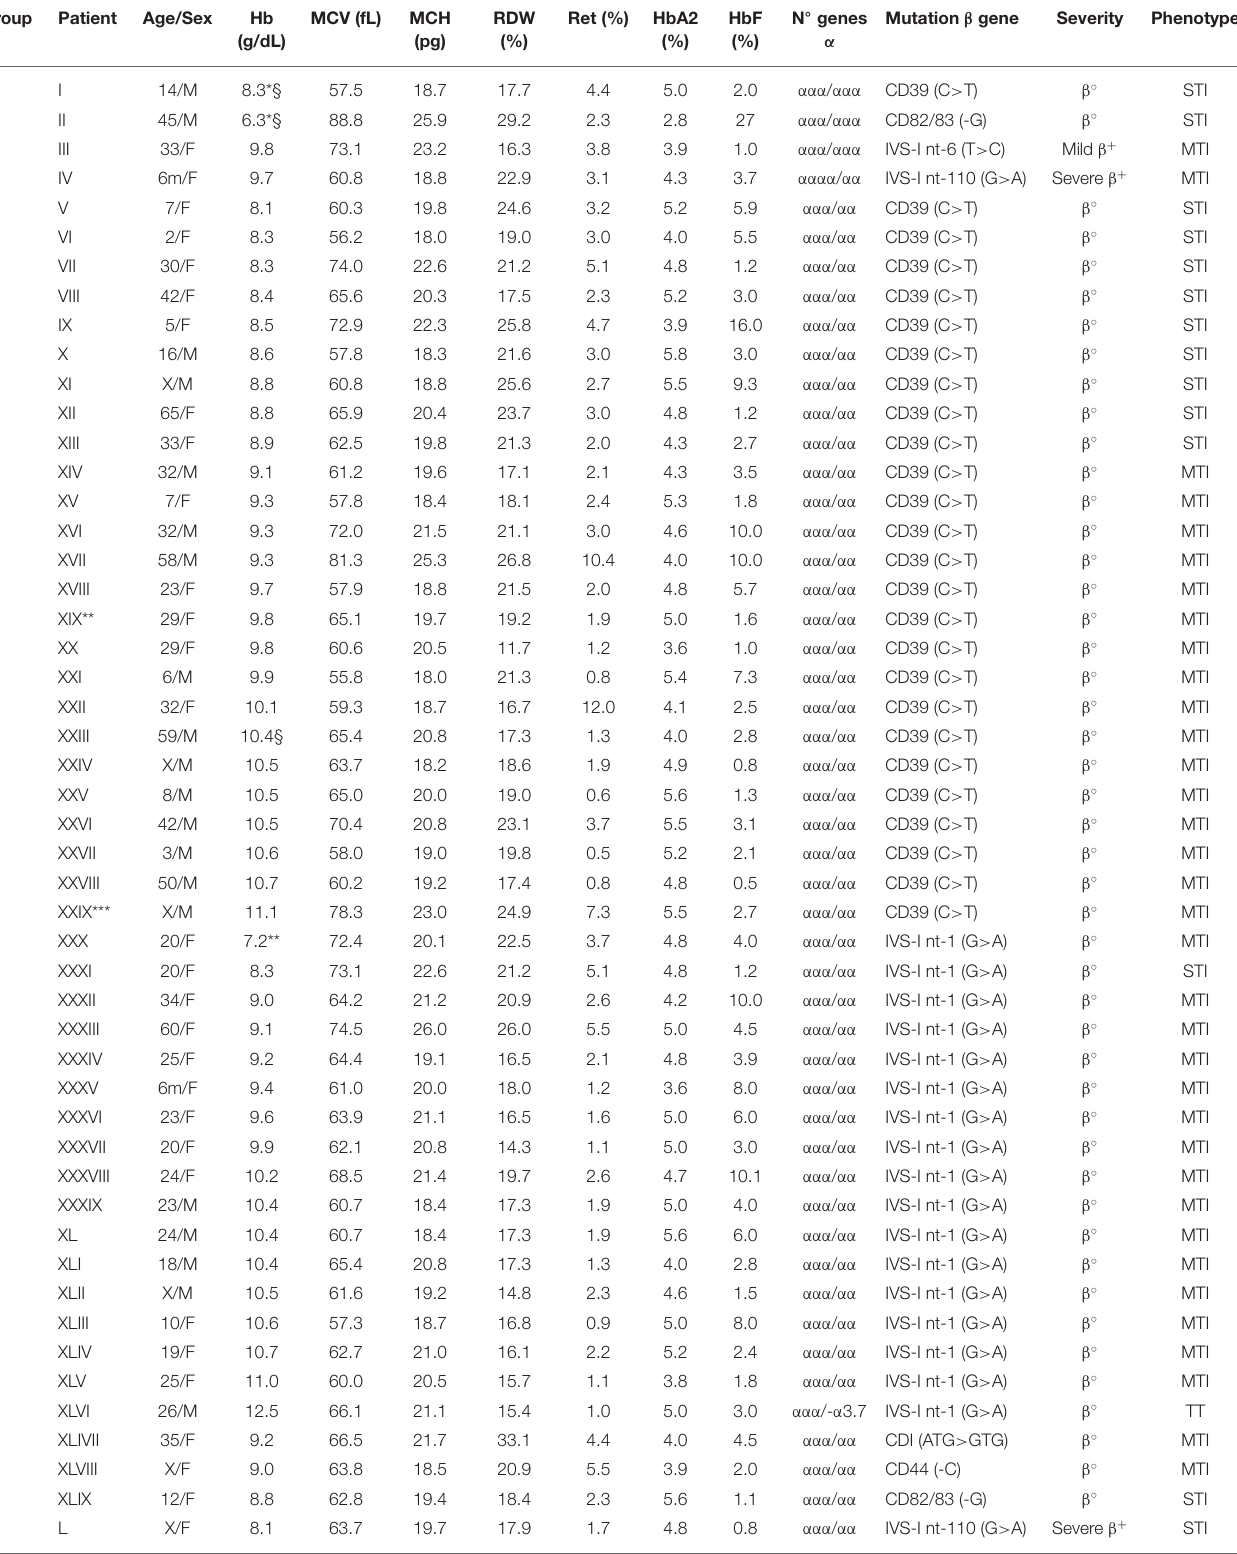
TABLE 3 | β -thalassemia associated with triplications of the α genes. Group Patient Age/Sex Hb